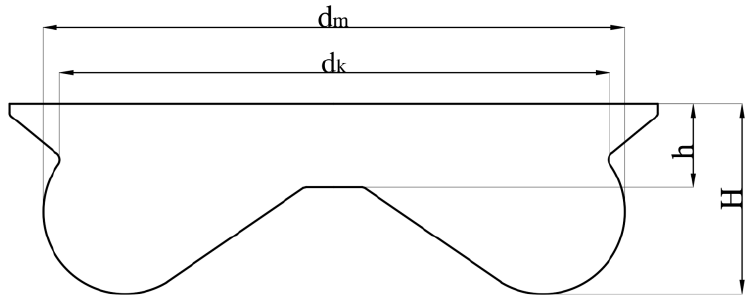
Figure 3. Structural diagram of combustion chamber.